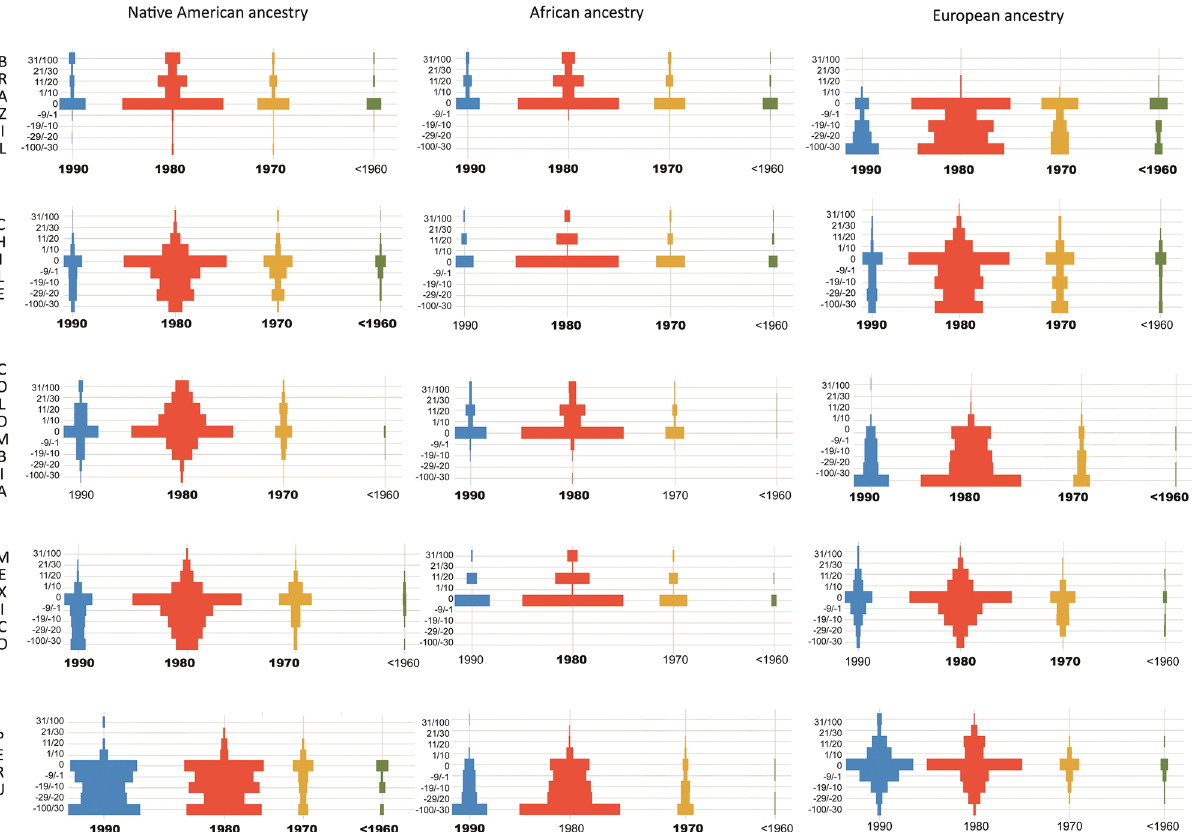
Figure 1. Vertical histograms (pyramid plots) showing the distribution of Delta (Δ) between ESP and genomic ancestry (y-axis) and birth decade (y-axis) separately for ancestry and country. If the percentage of genomic ancestry falls within a given ESP interval, then we considered the case as zero bias. If the bias is positive means that ESP exceeds the genomic estimate, whereas a negative result indicates that ESP is lower than its genomic counterpart. Birth decade in black show significant result to Wilcoxon signed-rank